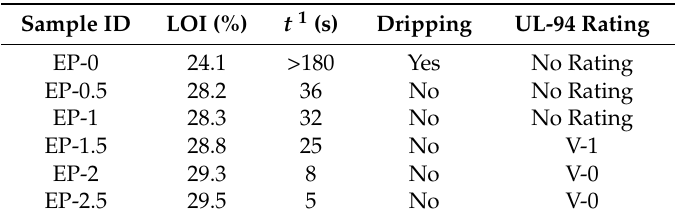
Table 1. LOI and UL-94 test results of cured epoxy.